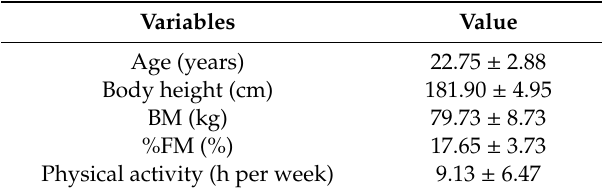
Table 1. Selected parameters of the tested males n = 20 (x ±